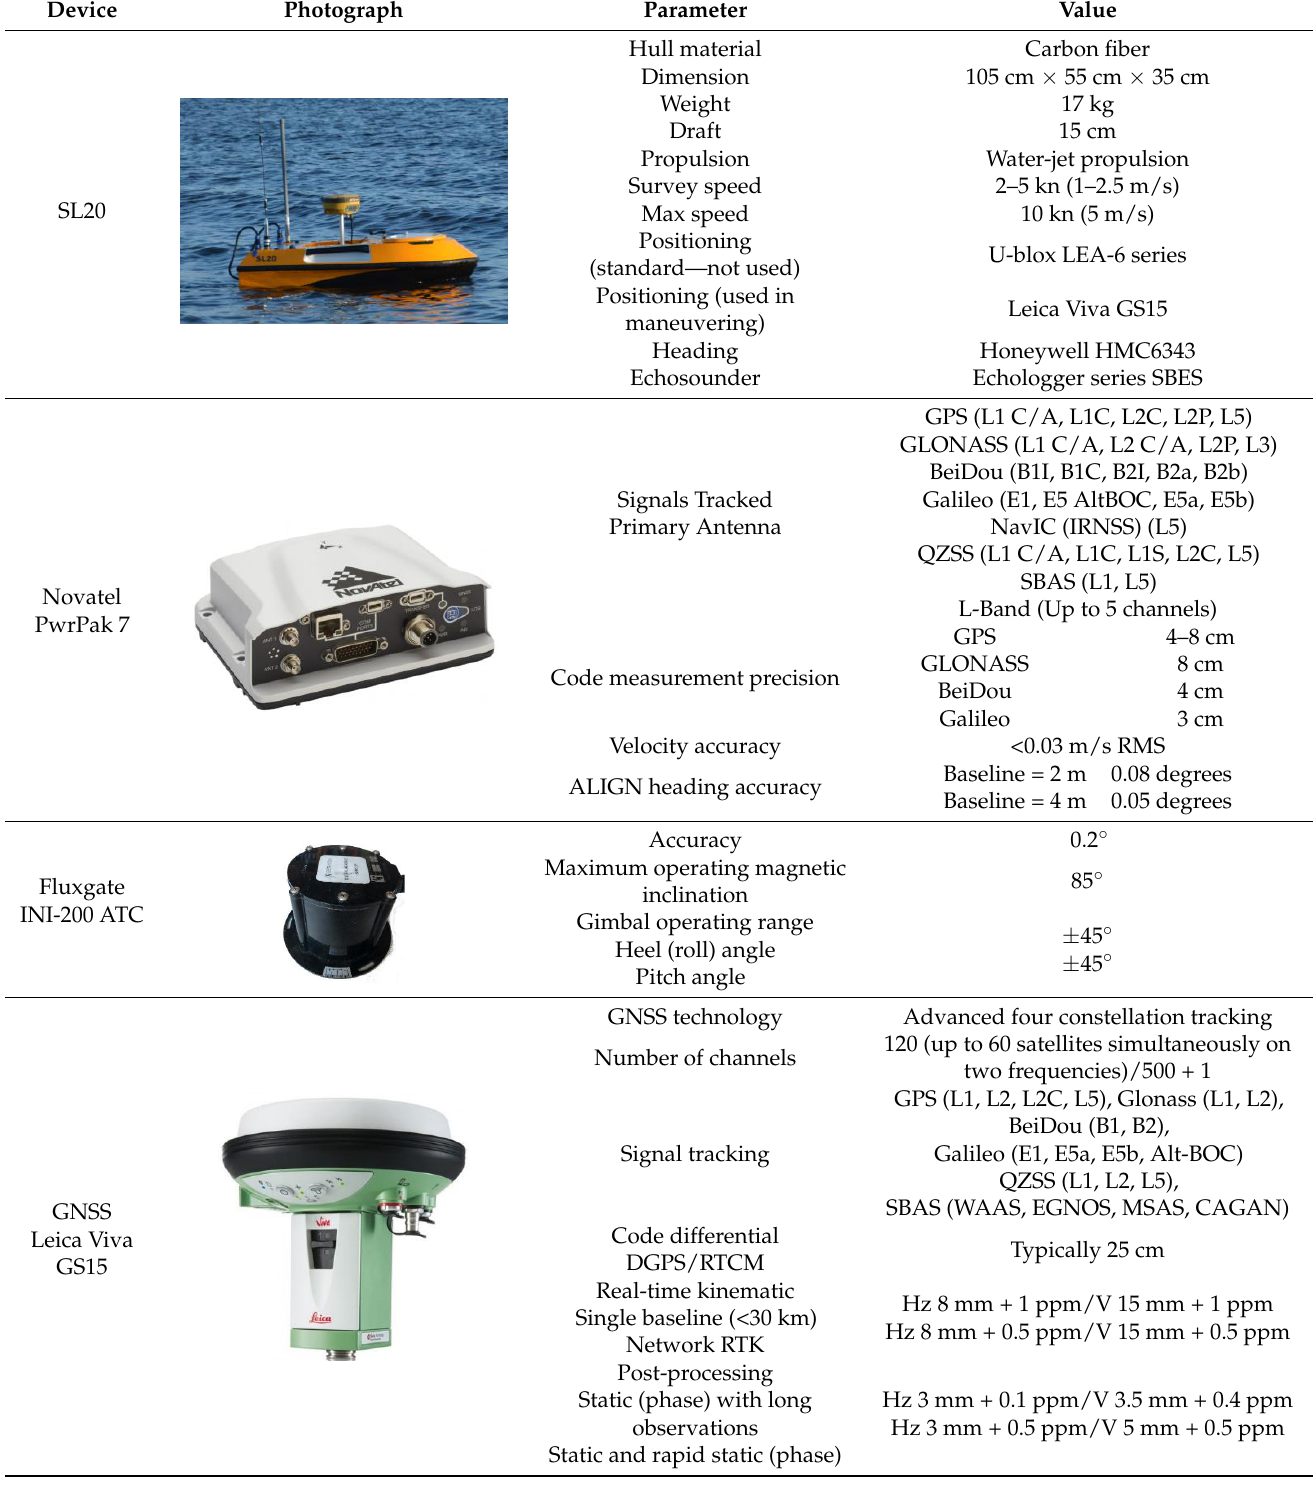
Table 1. Basic parameters of USV and sensors.